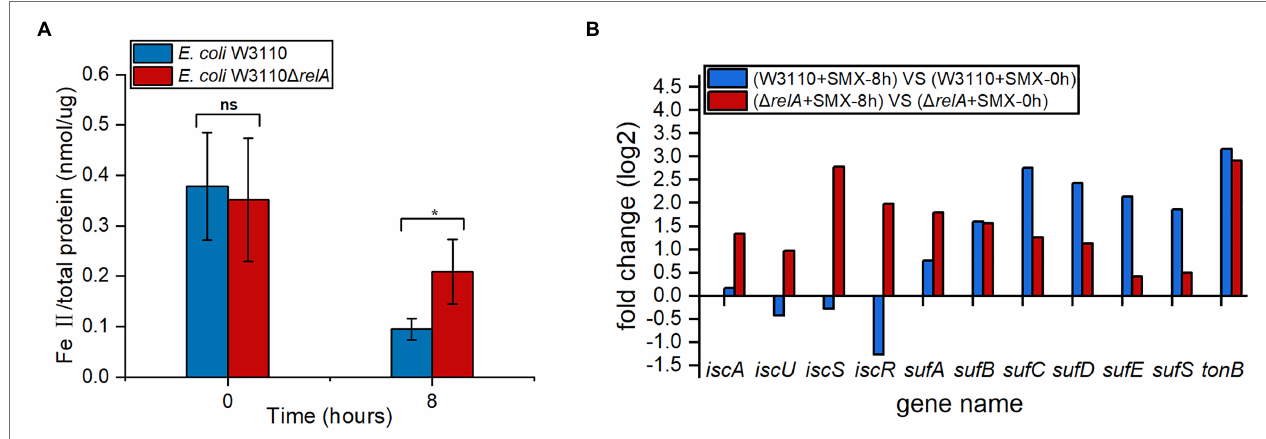
FIGURE 3 | Impacts of RelA on ferrous ion accumulation upon SMX treatment. (A) Internal levels of ferrous iron in Δ relA and the wild-type strain upon SMX treatment. Asterisks indicate statistically significant differences between means as determined by unpaired two-tailed Student’s t test (* p ≤ 0.05, ** p ≤ 0.01, *** p ≤ 0.001; ns, not significant p > 0.05). Error bars represent the standard deviation. (B) Expression levels of genes associated with iron transport and Fe-S cluster